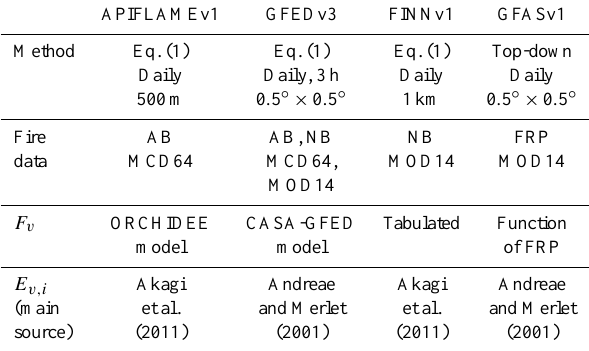
Table 6. Approaches and parameters used in the inventories com- pared. AB stands for area burned, NB for the number of active fires, and FRP for the fire radiative power.